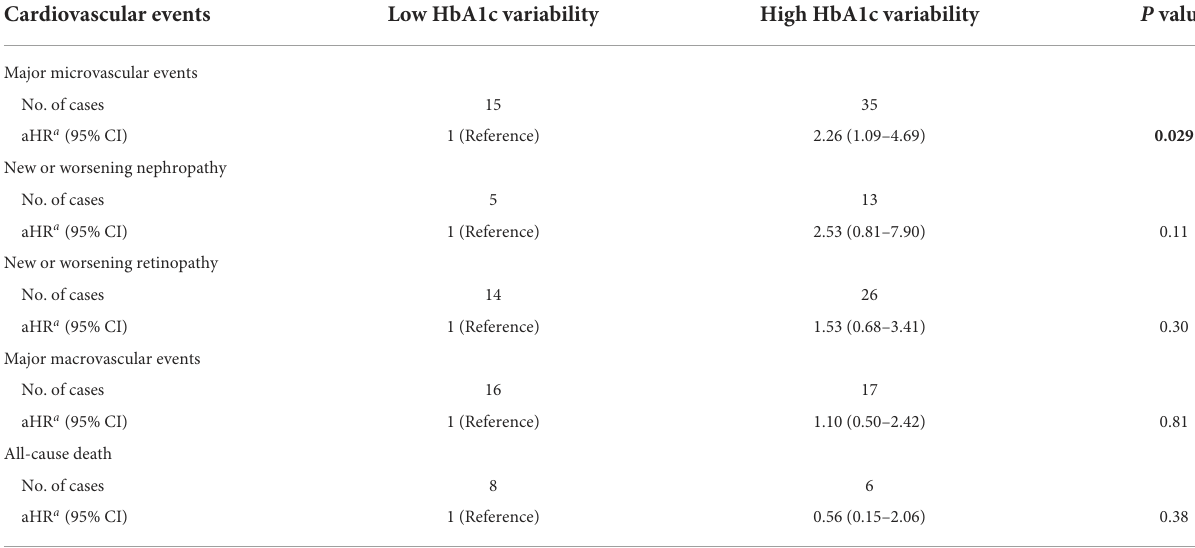
TABLE 4 The risk of cardiovascular events according to visit-to-visit HbA1c variability in patients of OTH group. Cardiovascular events Low HbA1c variability High HbA1c